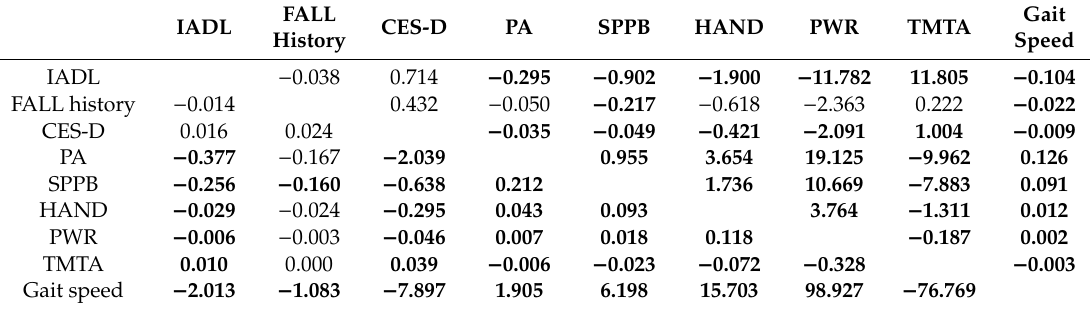
Table 10. Linear regression analysis between health-related